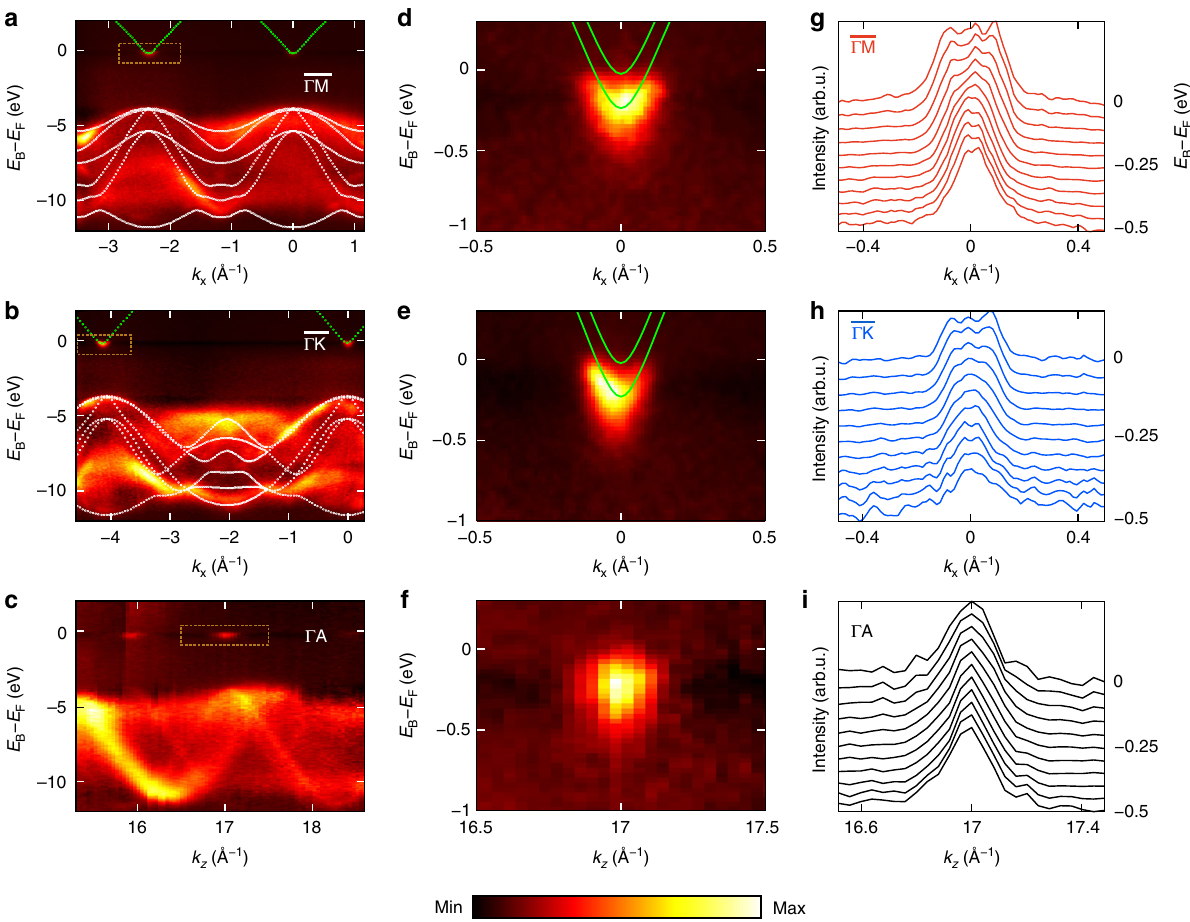
Fig. 4 Band dispersions of the buried 2DEG. a – c Experimental band structure measured at hv = 1066 eV for the a Γ K and b Γ M directions of the bulk BZ (superimposed with calculated E ( k ) of bulk GaN, white dashed lines) and under variation of hv for c Γ A, cf. Fig. 3. The CBM-derived QWSs appear above the VB continuum. d – f Zoom-in image of the QWSs around the Γ 10 -point (green lines schematize their dispersions fi tting the experimental k F ). g – i (Normalized) MDCs around the Γ 10 -point for a series of E B through the QWS bandwidth. The difference between the Γ M and Γ K dispersions manifests planar anisotropy of the 2DEG, and the absence of k z dispersion con fi rms its 2D character